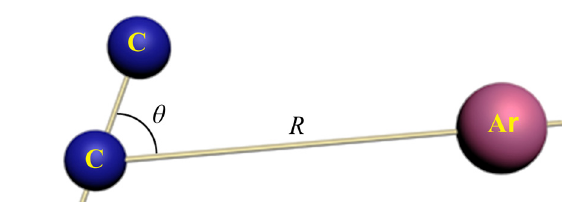
Figure 1: Jacobi coordinates for C